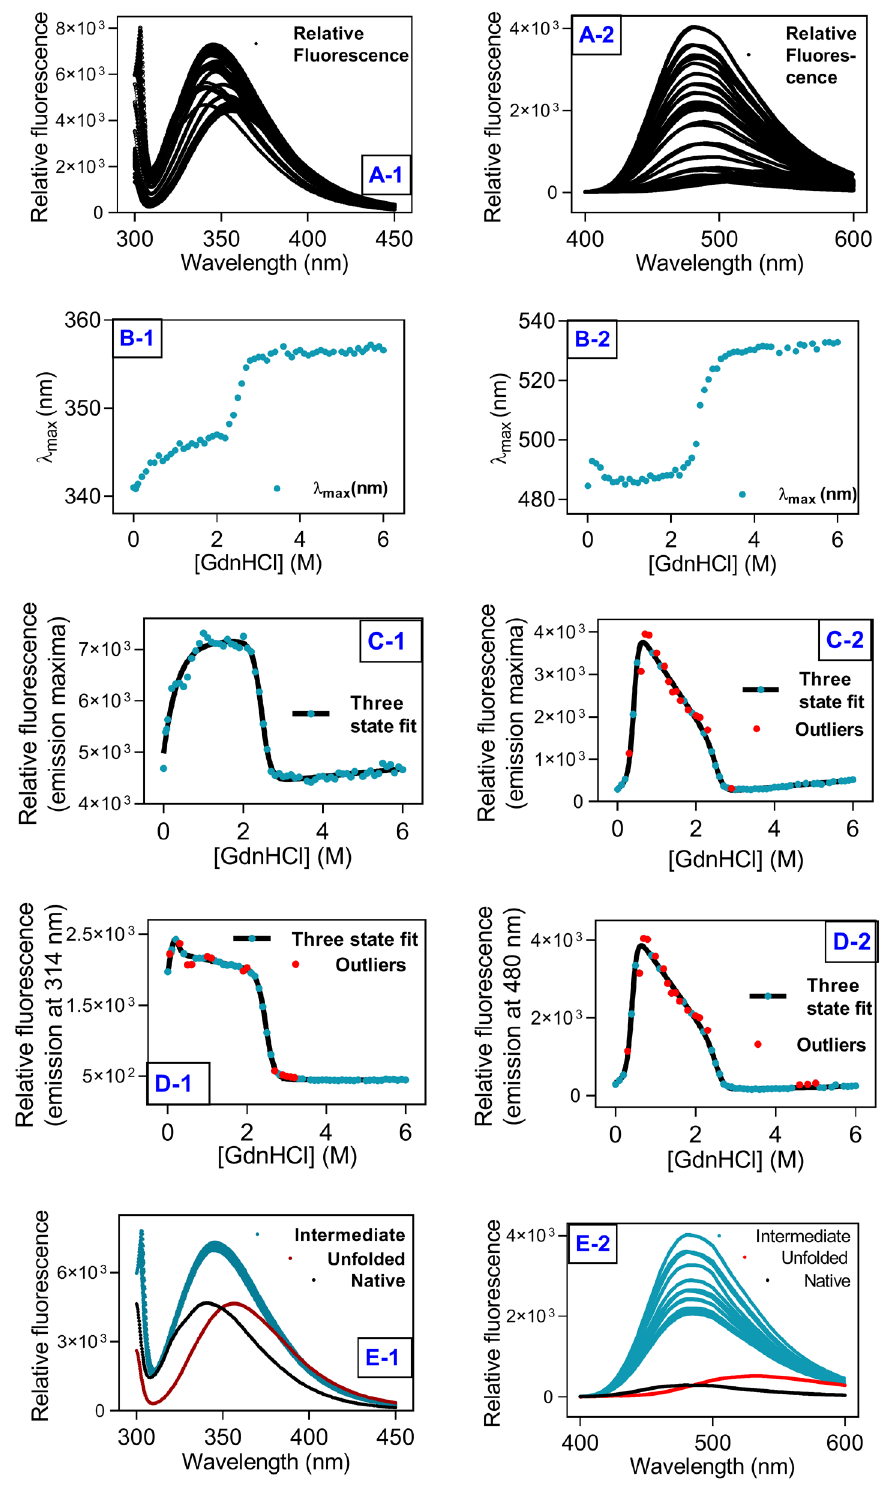
Figure 3. GuHCl-induced unfolding studies of human aldose reductase (hAR)monitored by fluorescence. ( A1 ) Trp fluorescence scans and ( A2 ) ANS fluorescence scans. ( B1 ) λ (Trp fluorescence) and ( B2 ) λ (ANS fluorescence) against [GuHCl]. ( C1 ) I (Trp fluorescence) max max max and ( C2 ) I (ANS fluorescence) against [GuHCl]. ( D1 ) I (Trp fluorescence) and ( D2 ) I (ANS fluorescence) against [GuHCl]. max 295/314 370/480 ( E1 ) Trp fluorescence and ( E2 ) ANS fluorescence of samples in native (black), intermediate (cyan), and unfolded state (red). Solid lines represent curves fitted to the unfolding transitions; filled symbols represent data points from unfolding experiments; red symbols represent outliers. Page 8